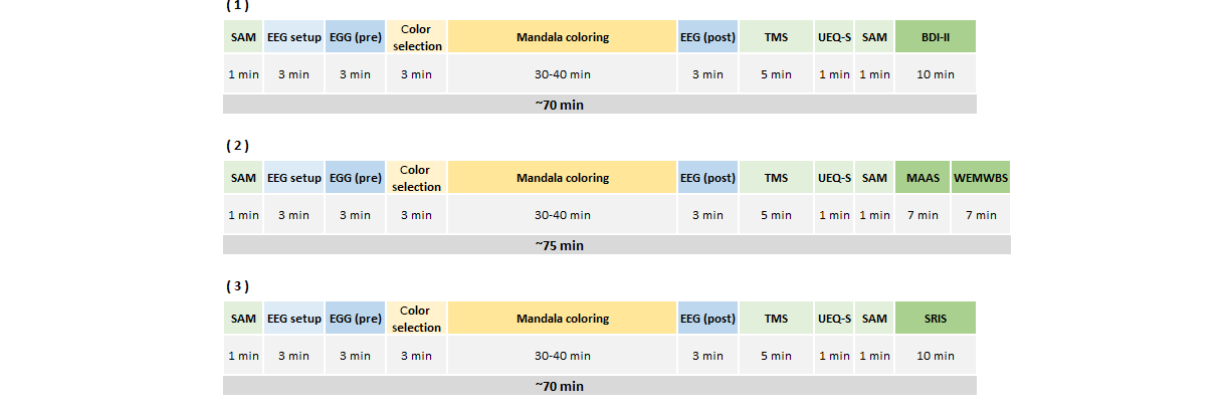
Figure 4. Triweekly mandala-coloring sessions during the intervention phase (in blue in Figure 3). To evaluate the effect of mandala coloring, data collection in each session will include pre- and post-EEG and measurements of emotional state (ie, SAM), mindfulness state (ie, TMS), and user experience (ie, UEQ-S). Trait measurements will be collected once a week. Hence, questionnaires will be distributed during the 3 sessions: BDI-II for depression symptoms in the first session, MAAS for trait mindfulness and WEMWBS for mental well-being in the second session, and SRIS for acceptance and reflection in the third session. BDI-II: Beck Depression Inventory second edition; EEG: electroencephalography; MAAS: Mindful Attention Awareness Scale; SAM: Self-Assessment Manikin; SRIS: Self-Reflection and Insight Scale; TMS: Toronto Mindfulness Scale; UEQ-S: User Experience Questionnaire short version; WEMWBS: Warwick-Edinburgh Mental Well-being